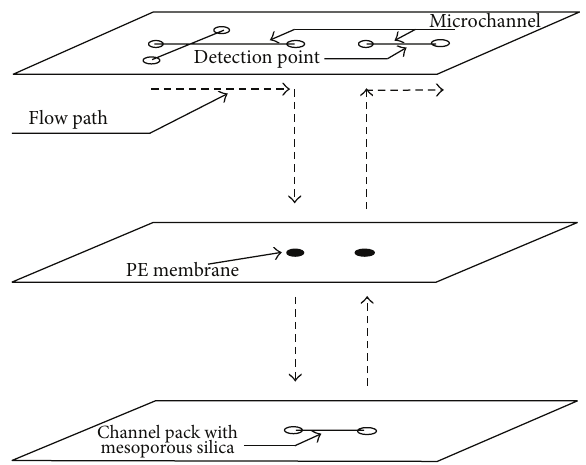
Figure1:Schematicdesignofapoly(dimethylsiloxane)microfluidic chip with integrated HPLC column using mesoporous silica. The dimension of the channel cross-section is 70 𝜇 m depth and 100 𝜇 m width. The diameter of reservoirs and PE membrane port is 2 mm. The silica column dimension was 5 mm long, 70 𝜇 m deep, and 100 𝜇 m wide. Figure2:Schematicdrawingoffabricationofnickelshimformicro-